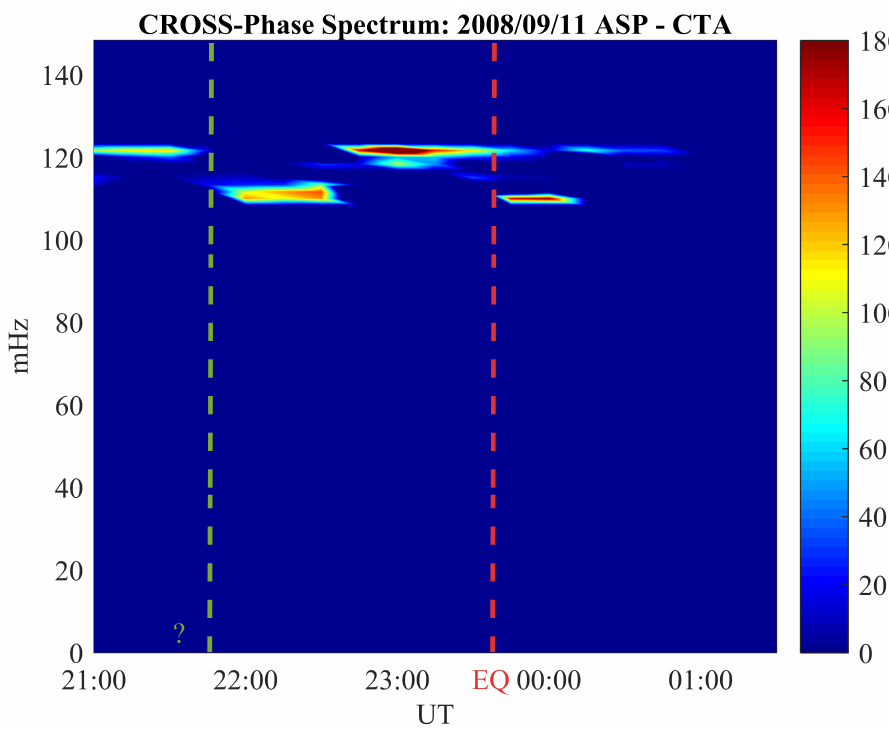
Figure 2. The cross-phase dynamical spectrograms for the Indonesia 11 September 2008 earthquake. Each spectrum has been evaluated over one hour interval. The spectra have been smoothed both in time and frequency domains (7 frequency bands and 15 temporal bands). The red vertical line represents the earthquake occurrence time. The green dashed line shows the occurrence of f ∗ decrease ∼ 2 h before the EQ main shock. The top caption reports the INTERMAGNET ground station codices used for the evaluation of the dynamical cross-phase spectrogram. The color-bar represents the phase difference in degrees between the equatorward and poleward ground